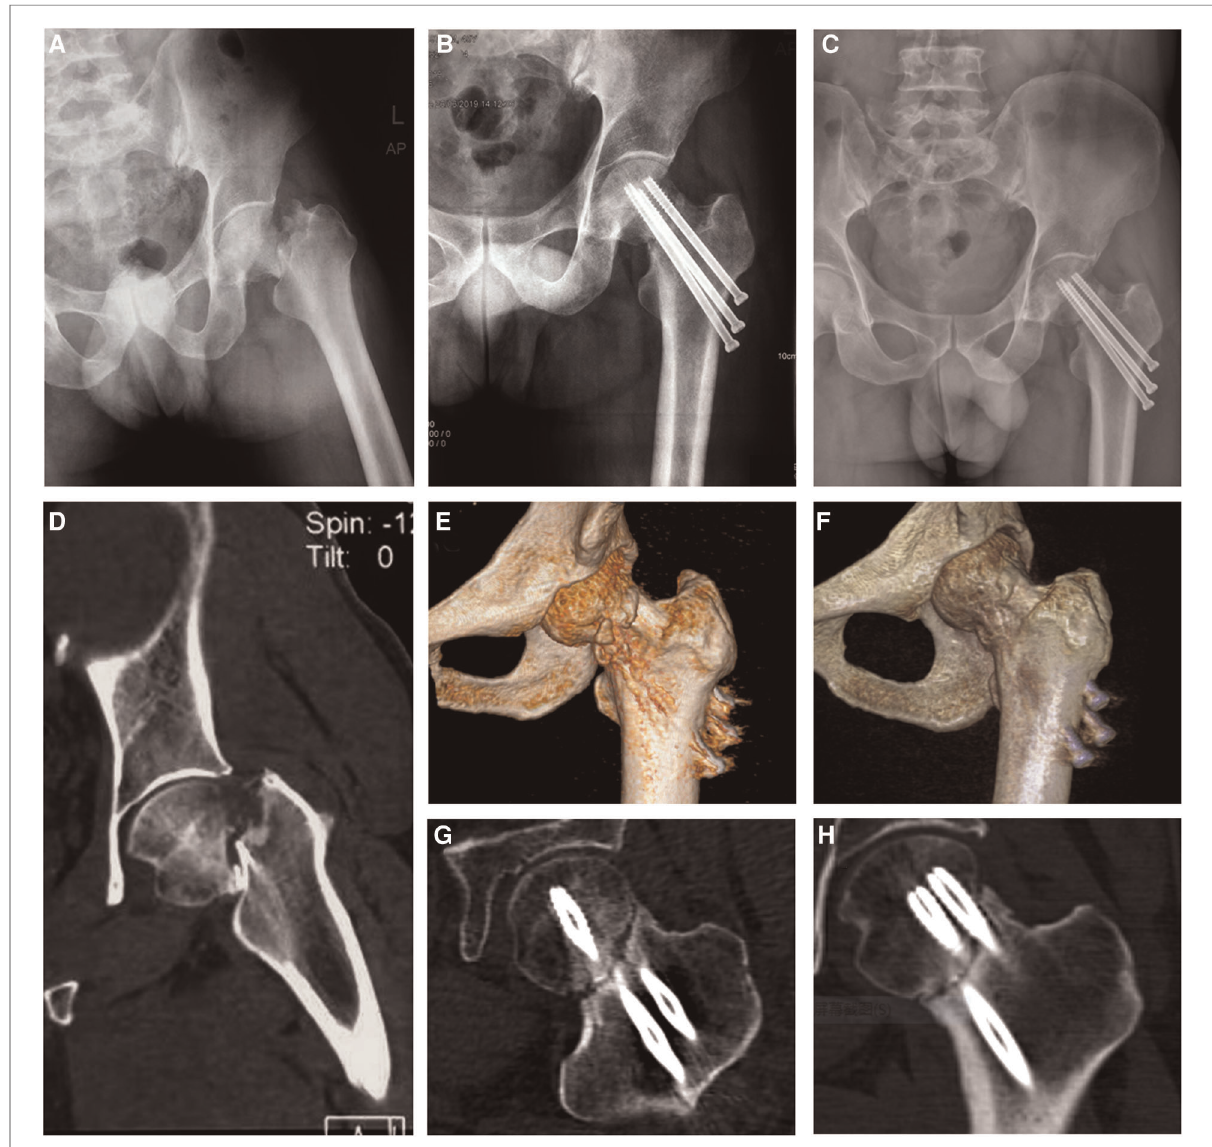
FIGURE 1 X – ray ( A ) and CT ( D ) showing a Garden IV fracture of the left femoral neck. The x-ray ( B ) and CT ( E,G ) showing bone resorption at the fracture site with internal fi xation loosening and slipping 8 weeks after operation. The x-ray ( C ) and CT ( F,H ) showing the non-union of fracture 12 weeks after operation when the patient fi rst visited our hospital and was started on a subcutaneous injection of